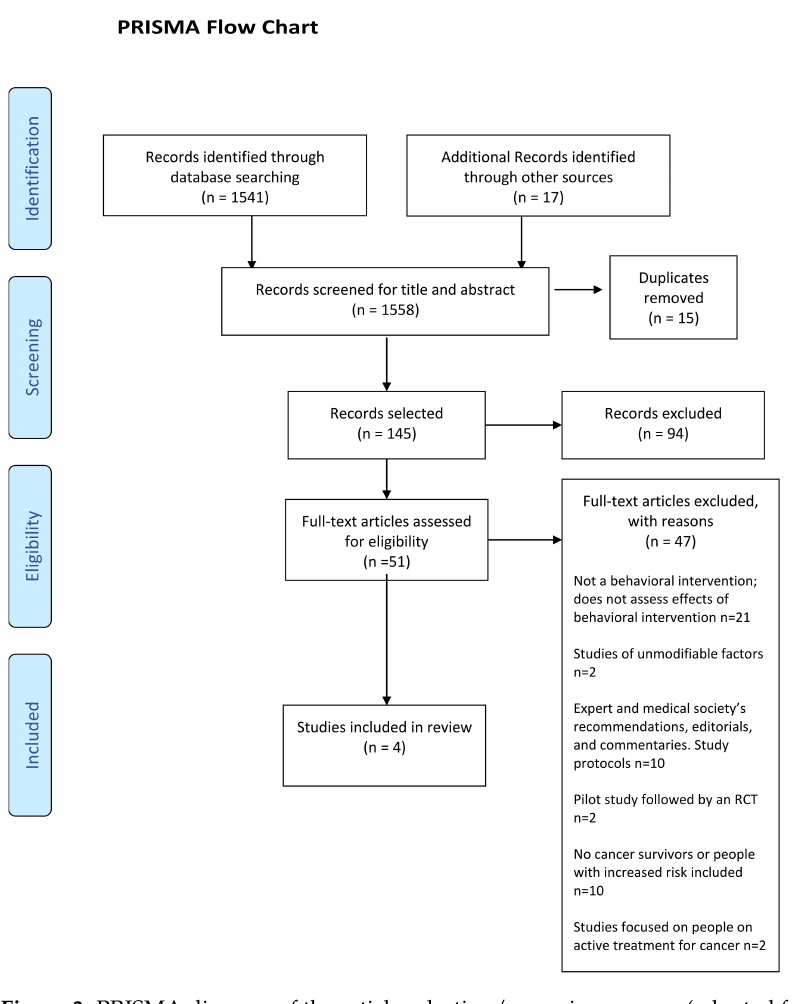
Figure 3. PRISMA diagram of the article selection/screening process (adapted from